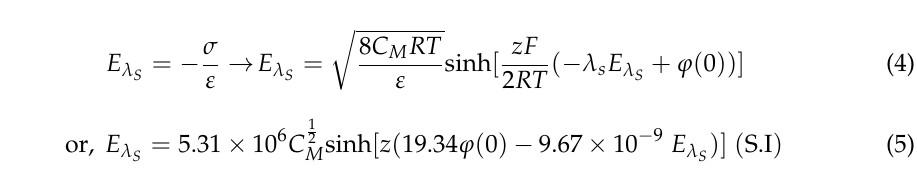
Figure 4. Surface charge density |𝜎| ( C m (cid:2870) (cid:3415) ) as a function of 𝐶 (cid:3014) (mol m (cid:2871) (cid:3415) ) for z = 2 ions and various 𝜑(0)(𝑉) (discrete points). Solid lines are the corresponding |𝜎 (cid:3039) | values.